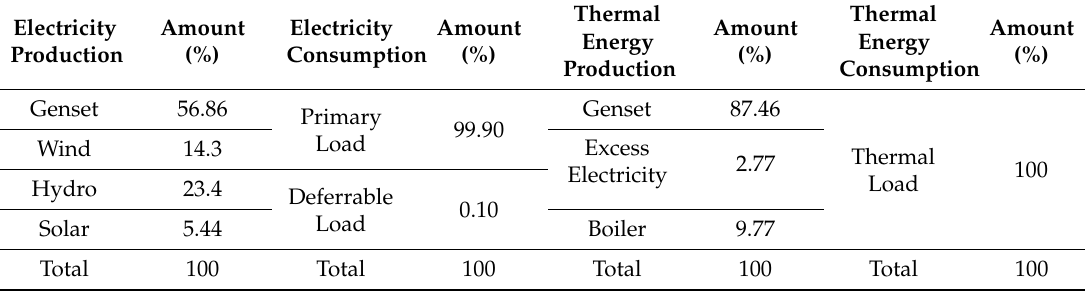
Table 12. Energy production and consumption scenario of o ff -grid mode for the first year of project life